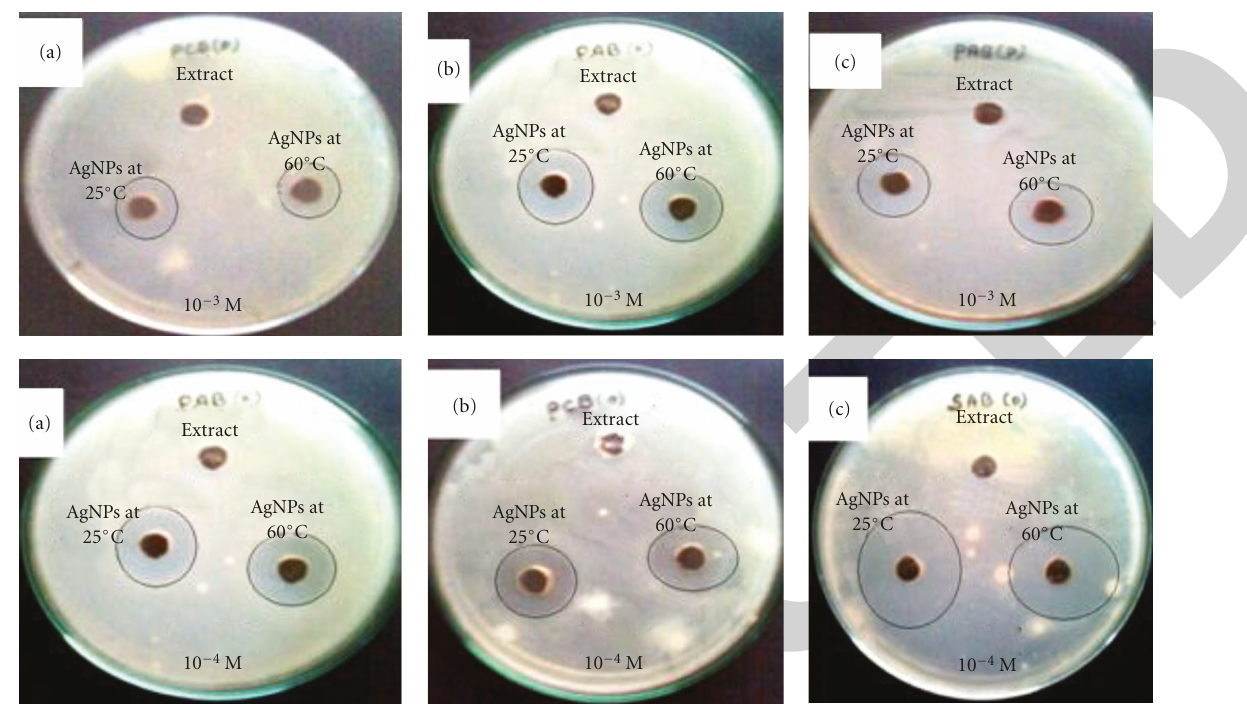
Figure 4: Zone of inhibition of silver nanoparticles against (a) Escherichia coli , (b) Pseudomonas aeruginosa , and (c) Staphylococcus aureus .